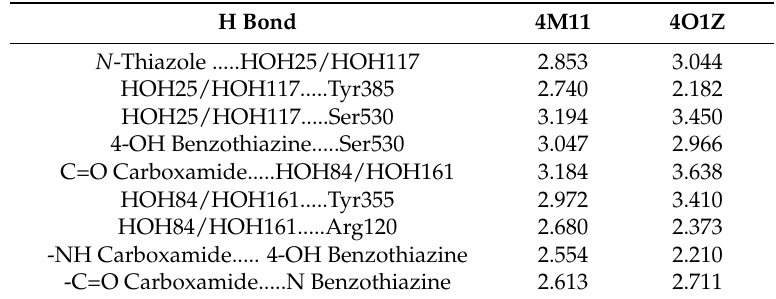
Table 2. Hydrogen bond distances (Å) registered for meloxicam docked in cyclooxygenase COX-1 and COX-2 (Protein Data Bank (PDB) ID: 4M11 and 4O1Z).